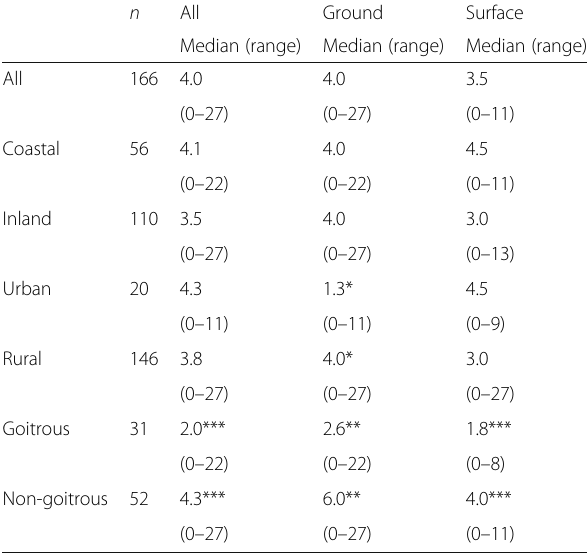
(Table 2). The difference was diminished and not signifi- cant for median WIC between surface water from urban